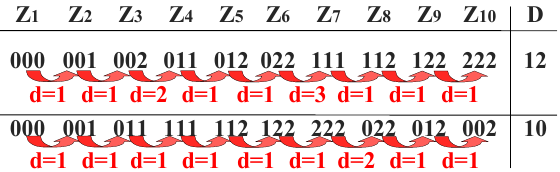
Figure 3. Sum of Manhattan distances for different solution space arrangements ( M = 3, N = Algorithm 2: NBACO-SS algorithm